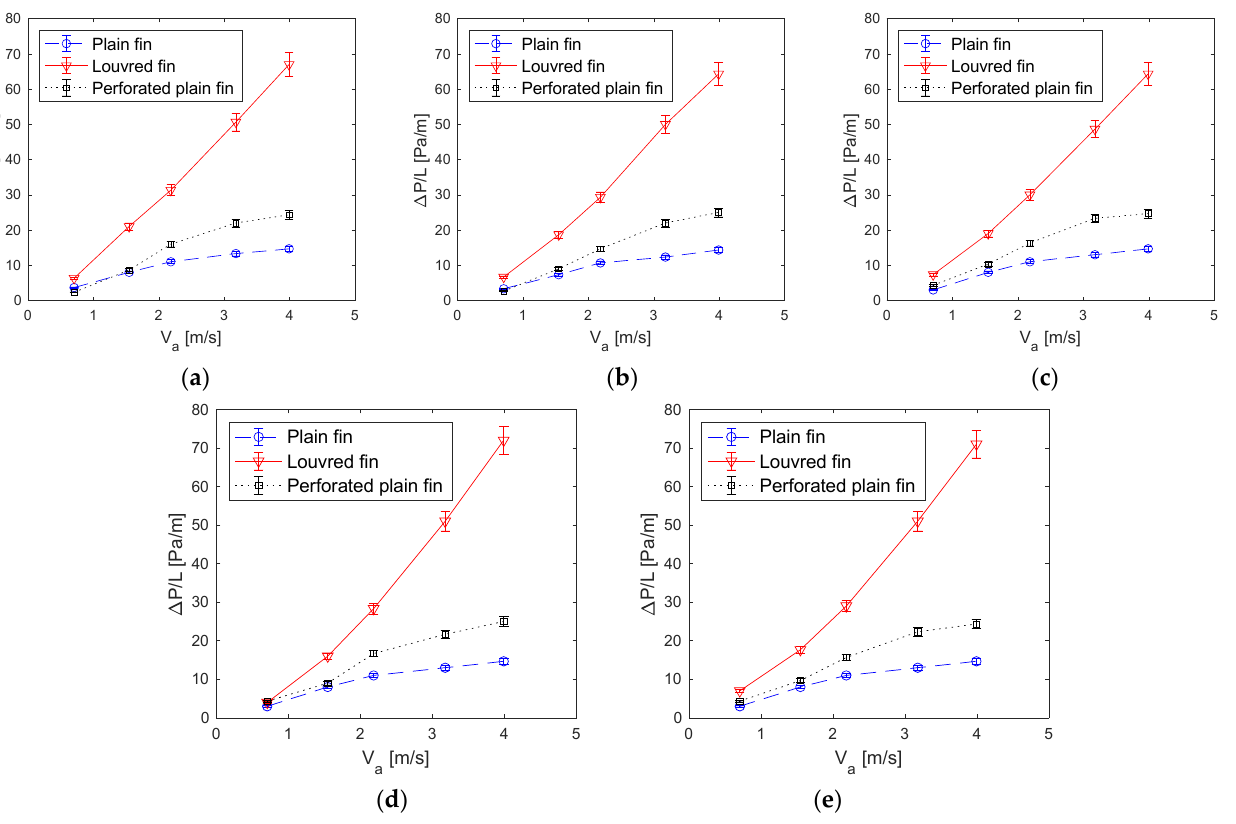
Figure 6. Variation of ( ∆ P / L [ Pa/m ]) against V a for various heat exchanger; ( a ) at water flow rate of 0.12 m 3 /h, ( b ) at water flow rate of 0.18 m 3 /h, ( c ) at water flow rate of 0.24 m 3 /h, ( d ) at water flow rate of 0.3 m 3 /h and ( e ) at water flow rate of 0.36 m 3 /h. Looking at the heat transfer characteristics and corresponding pressure drops associated with different geometries (Figures 6 and 7), it can be seen that quantitatively, at the lowest water flow rates of 0.12 m 3 /h, an increase in heat transfer rate was noticed for the louvred fins as compared to plain fins (about 13% lower) and plain perforated fins (2.7% lower). These values change to about 15% for plan fins and 6% for the perforated plain fin model at a water flow rate of 0.18 m 3 /h. At flow rate of 0.24 m 3 /h again the corresponding values were 13% and 11%. However, such significant increase of the heat transfer was made at the expense of a significant air pressure drop (Figure 6). It is assumed that the perforated fins increased the flow vorticity. At 0.3 m 3 /h almost similar levels of change in heat transfer rate was noticed. In general, there is an increasing trend in heat transfer as the water flow rate increases for all types of heat exchangers. This is evidenced by an increase in the rate of heat transfer from about 500 to 600 W for louvered fins heat exchanger, 400 W to 523 W for plain fin heat exchanger, and 488 to 528 W for perforated plain fin heat exchanger at V a = 4 m/s. Nevertheless, the perforated plain fin model appears to be least affected by an increase in water flow rate. Its heat transfer rate has only marginally increased at higher water flow rates. This may be because the perforations have reduced the heat transfer area below a certain threshold where the fluid flow rates can have a significant effect. As a result, in certain situations this aspect should be kept in view whilst designing a perforated plain heat